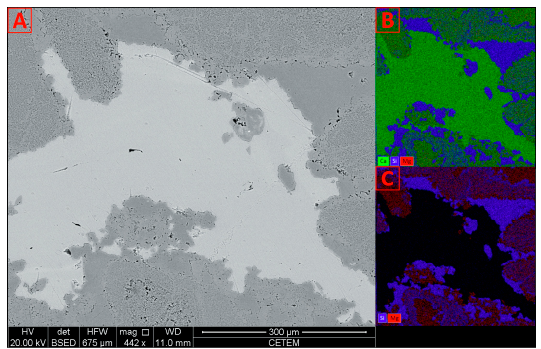
Figure 7. Sample PA13, ( A ) backscattered electrons image with brighter calcite, “smooth” gray quartz and dolomite; ( B ) dot map for Ca, Si and Mg, showing blue quartz, light green calcite and dominant dolomite II in dark green. A small, darker, area at the bottom shows a higher Mg content, corresponding to dolomite I; ( C ) dot map only for Si and Mg, showing blue quartz and red dolomite II. The dolomite I area at the bottom also contains higher Si contents, and is interpreted as sub-micrometric intergrowth of dolomite with quartz.